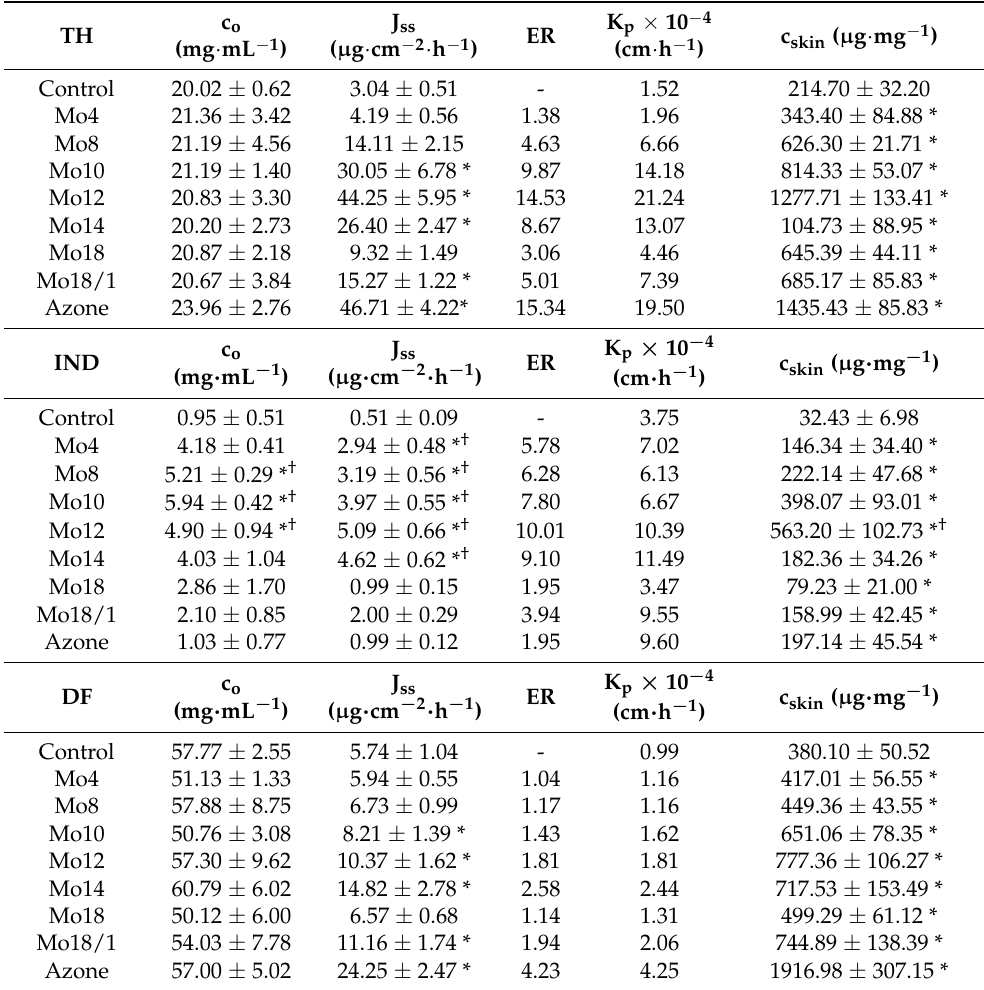
Table 2. Effects of the studied enhancers (1%) on the permeation of the model drugs applied at 2.5% w / v (IND) and 5% w / v (TH, DF) in 60% PG with or without the enhancer. Solubility of model drugs in the donor samples (c o ), steady-state flux values (J ss ), enhancement ratio (ER), permeability coefficient (K p ), the concentration of model drugs in the skin (c skin ). Data are presented as the means ± SEM, n ≥ 16. * Statistically significant difference compared to the negative control (without enhancers) at p < 0.05. † Statistically significant increase compared to a positive control (with Azone) at p < 0.05. c o TH (mg · mL − 1